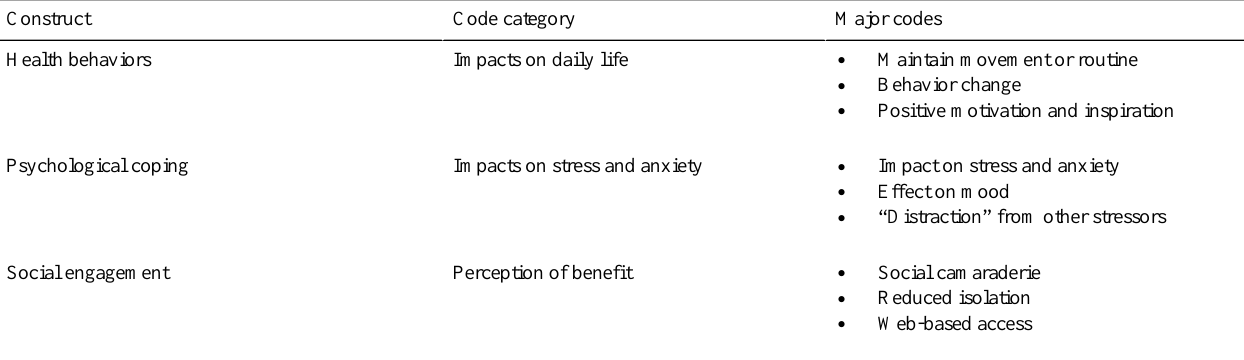
Table 2. Major theoretical constructs and associated